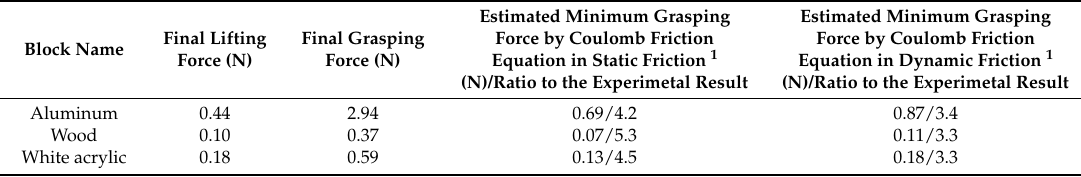
Table 3. Result of grasping force control tests and their estimated